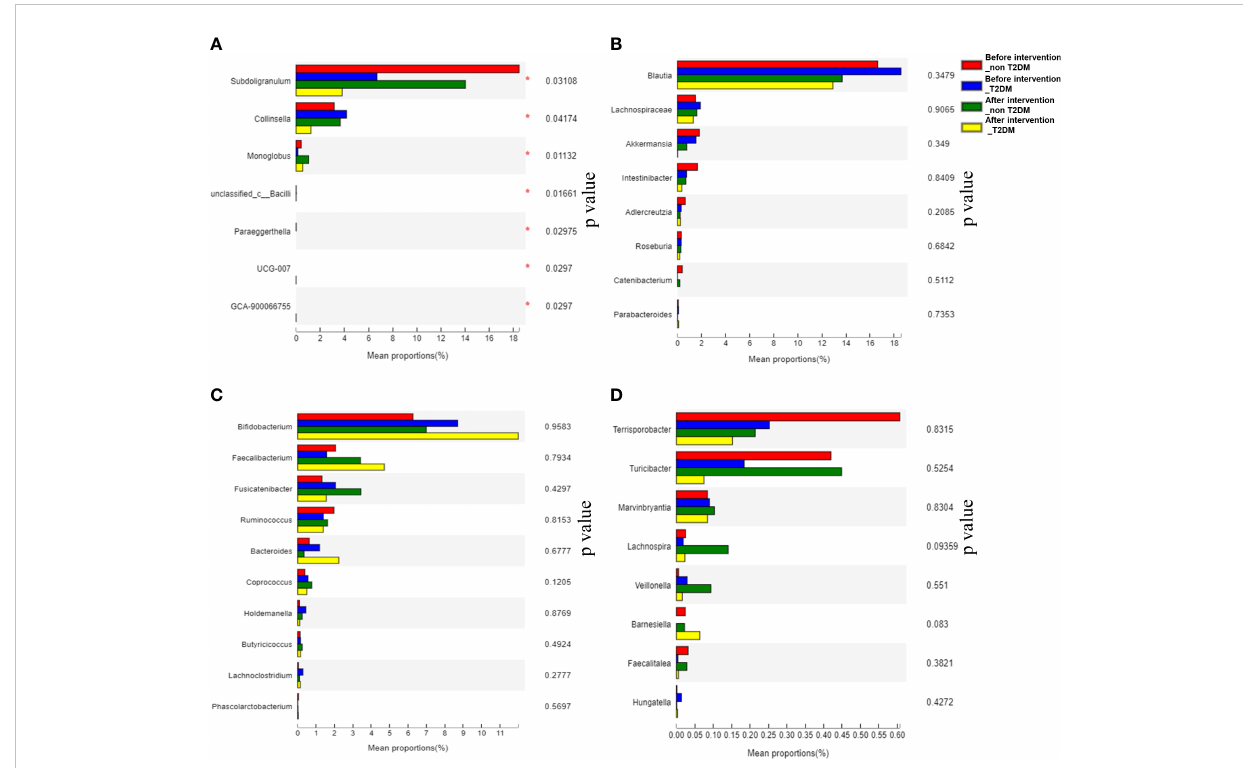
FIGURE 6 Analysis of signi fi cantly altered gut microbiota and speci fi c species microbiot in T2DM patients and non-T2DM patients after two years of probiotics intervention. (A) Analysis of signi fi cantly altered gut microbiota; (B) Analysis of metabolism-related microbiota; (C) Analysis of producing short-chain fatty acids-related microbiota; (D) Analysis of gut probiotics.